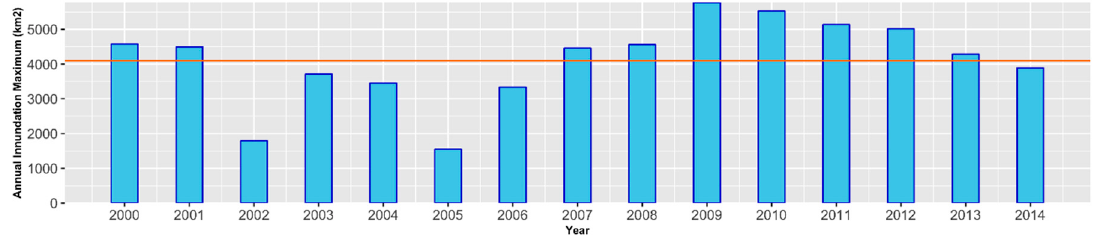
Figure 7. Derived annual inundation maximums from 2000 to 2014. The long-term average of 4097 km 2 is shown.